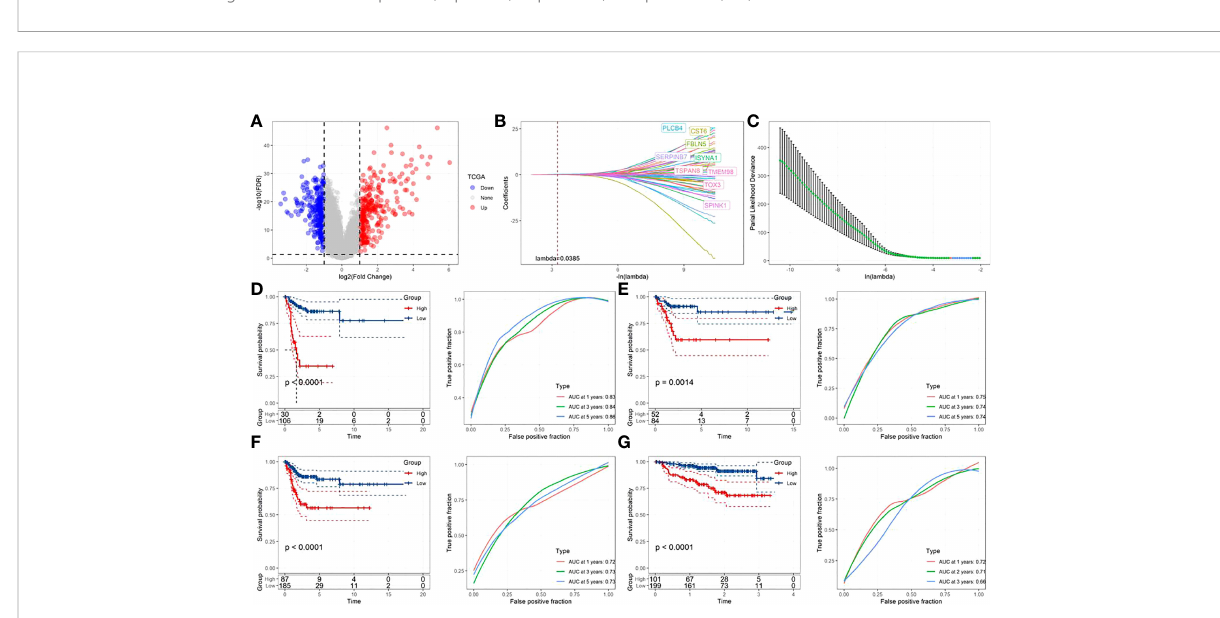
FIGURE 8 Construction and veri fi cation of prognostic correlation model of FamRGS (A) Volcanic map of the variation analysis of molecular subtypes; (B) The changing trajectory of each independent variable, with the horizontal axis representing the log value of the independent variable lambda, and the vertical axis representing the coef fi cient of the independent variable; (C) Con fi dence interval under each lambda; (D) AUC curve and KM curve of the risk model of the training set data from TCGA; (E) AUC curve and KM curve of the risk model of the veri fi cation set data from TCGA; (F) AUC curve and KM curve of the risk model of all data sets from TCGA; (G) AUC curve and KM curve of the risk model of data set from